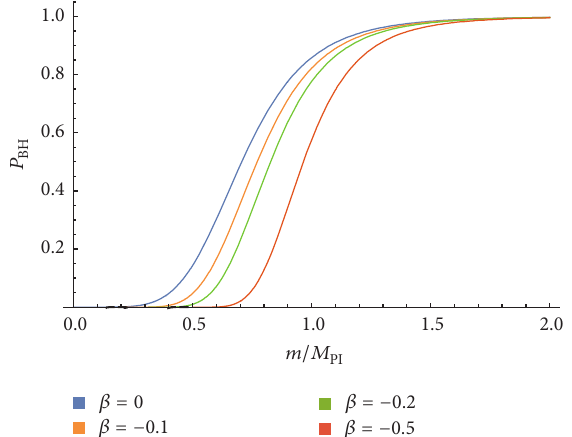
Figure 2: Probability 𝑃 BH (𝑚) for a particle to be a black hole for increasing values of the free parameter 𝛽 versus mass of the particle. Dashed lines correspond to values where 𝑚/𝑀 Pl < √𝛽/2𝑀 Pl .